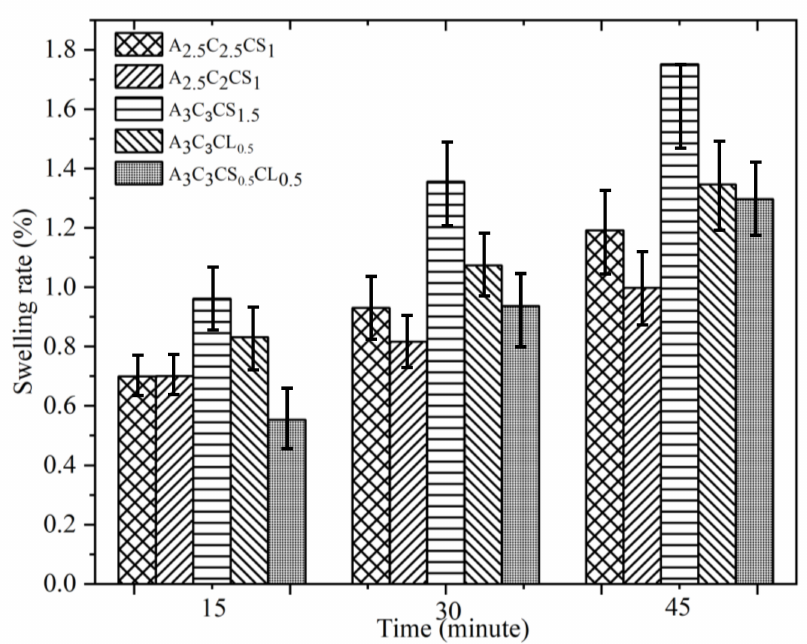
Figure 16. Result of swelling test for various compositions at different times. Statistically, it showed a significate difference ( p < 0.05) with respect to the various times we used (15, 30, 45